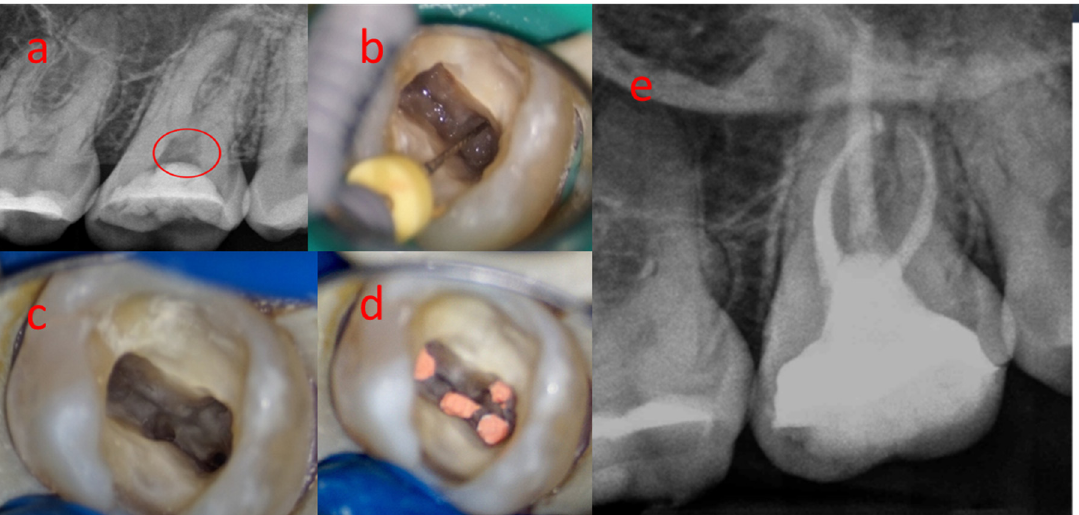
Figure 2. Removal of pulp mineralization followed by endodontic treatment: ( a ) Preoperative radiograph; ( b ) Identification of canal orifices; ( c ) The pulp chamber after the pulp stone removal; ( d ) Tooth after the endodontic treatment; ( e ) Postoperative radiograph.